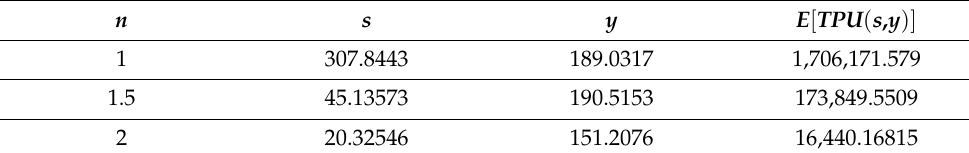
Table 4. Optimal Solution for Example 4 for n =